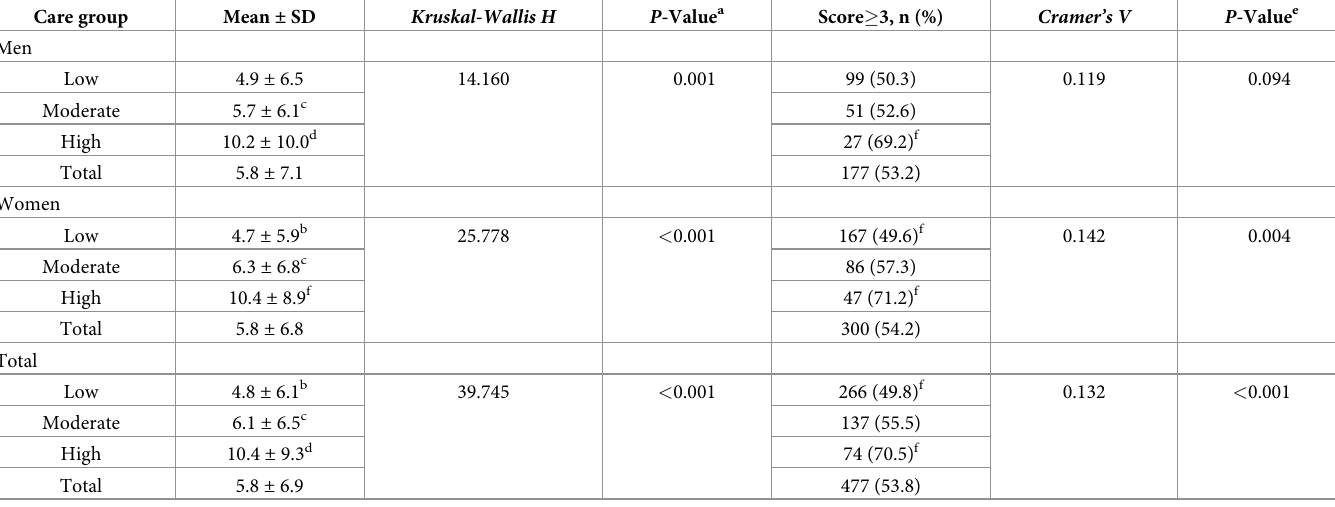
Table 6. Eating Assessment Tool (EAT-10) scores in long-term care insurance